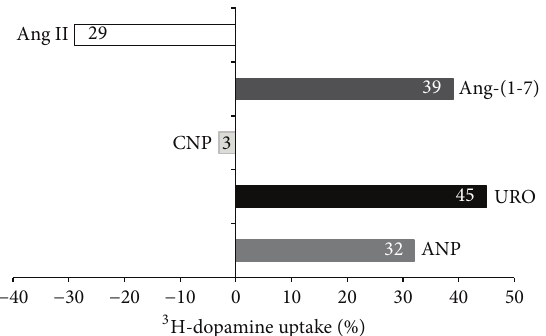
Figure4:Comparisonofdifferentvasoactivepeptideseffectson 3 H- dopamineuptakeinexperimentscarriedout invitro inisolatedrenal cortex samples. 3 H-dopamine uptake is expressed as percentage of uptake respect control group.